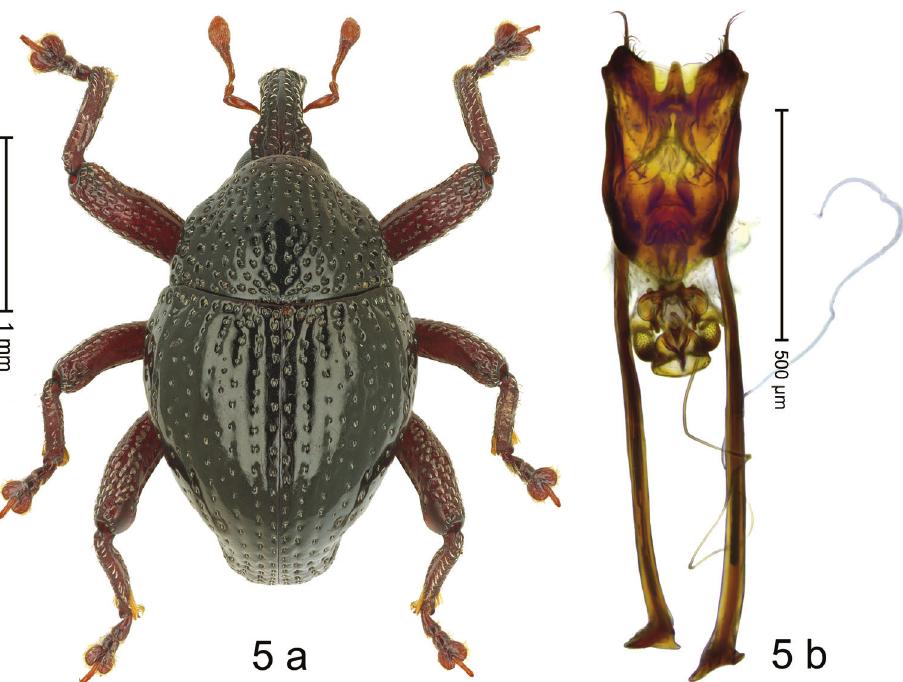
Figure 5. Trigonopterus dakoensis sp. nov., holotype a habitus b